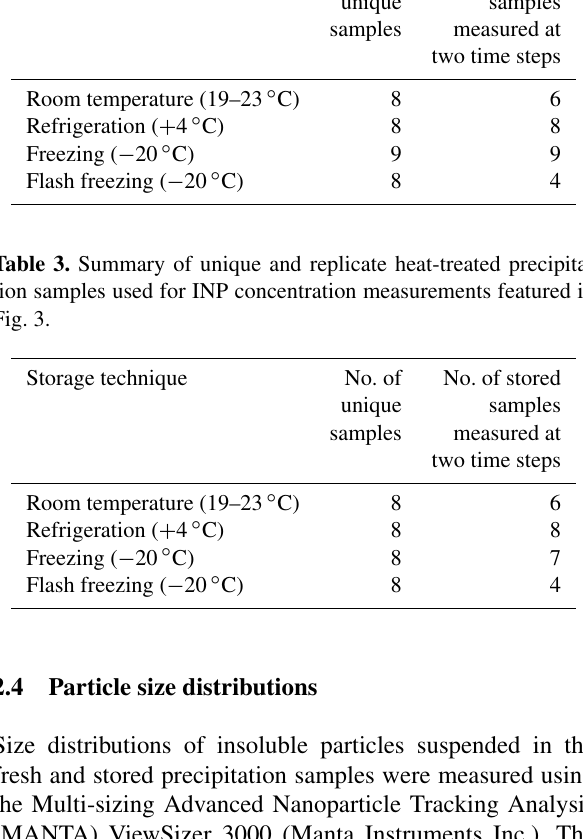
Table 2. Summary of unique and replicate untreated precipita- Table 4. Summary of unique and replicate filtered (0.45µm) precip- tion samples used for INP concentration measurements featured in itation samples used for INP concentration measurements featured Fig. 2. in Fig. 4. Storage technique No. of No. of stored Storage technique No. of unique unique